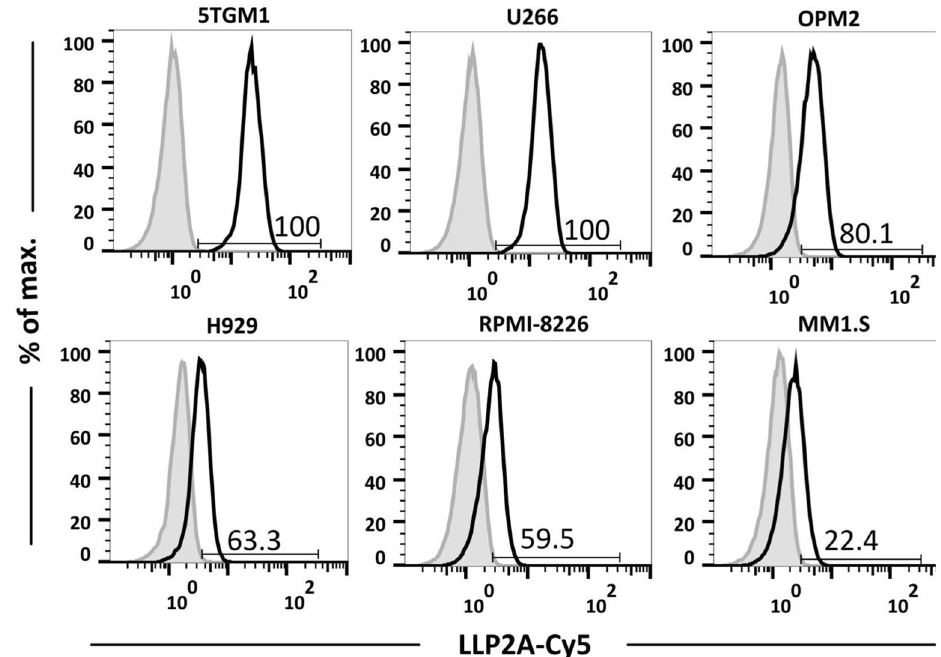
Figure 5. LLP2A-Cy5 binding to diverse MM cell lines. Flow cytometry was performed to evaluate binding of LLP2A-Cy5 to different myeloma cell